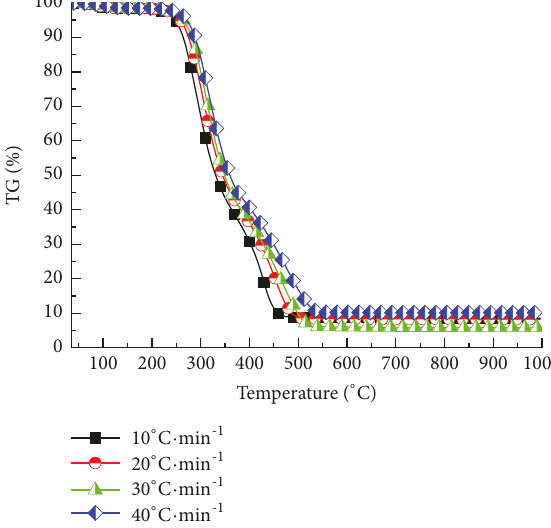
Figure 1: Combustion TG curves of wood